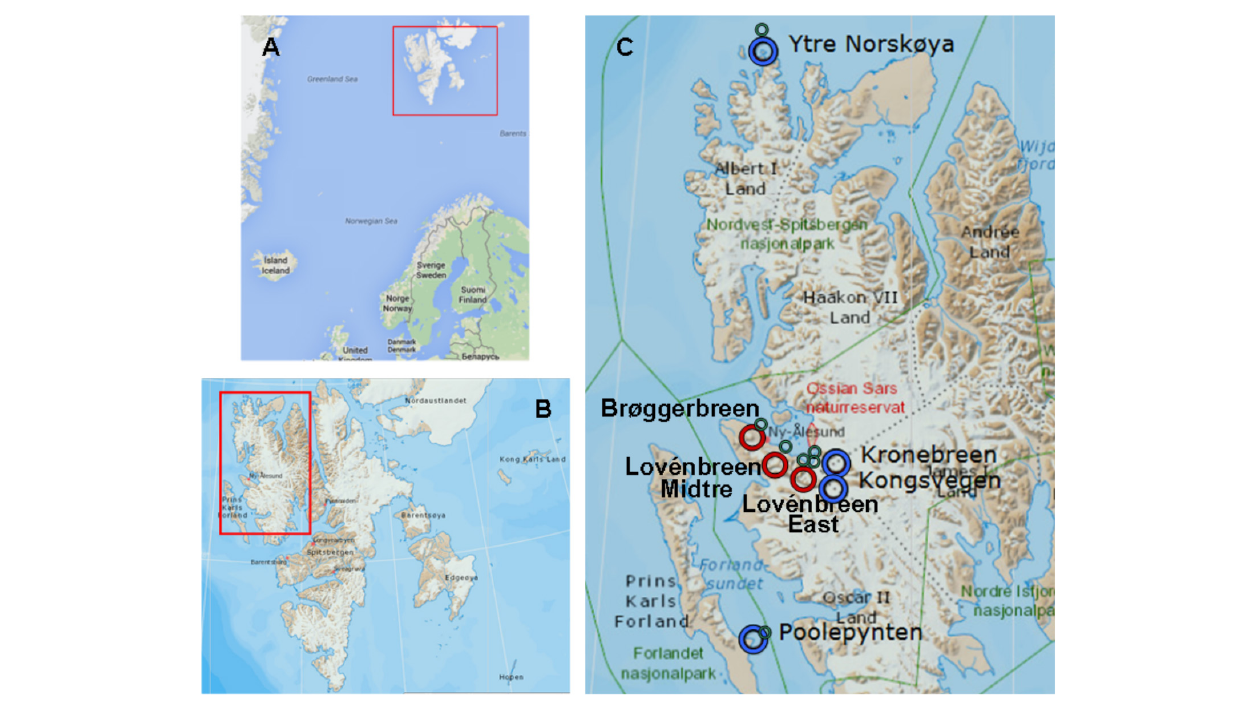
FIGURE 1 | Geographic maps the Arctic Svalbard archipelago. (A) Svalbard archipelago. (B) Spitsbergen and Prins Karls Forland. (C) Map showing the distribution of ice samples collected at marine glaciers (blue rings), inland glaciers (red rings) and tidewaters tongues (green rings). Image sources: Google maps (A) and TopoSvalbard (Copyright Norwegian Polar Institute) (B,C) .